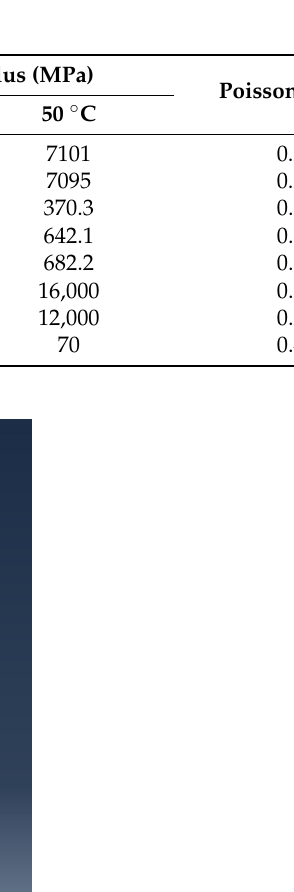
Table 5. Working condition